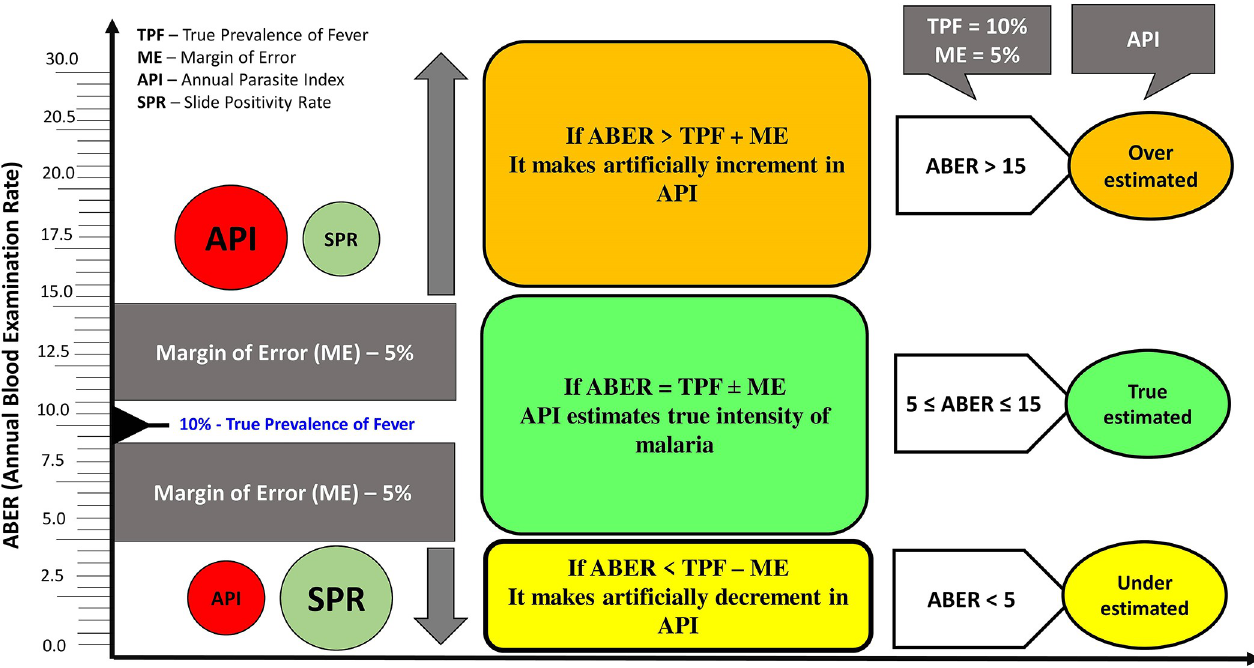
Fig 5. Schema of relationship between API, SPR, ABER and true prevalence of fever. https://doi.org/10.1371/journal.pgph.0000326.g005 with API < 1) despite Ganjam having a slightly higher number of cases. Even Koraput (district of Odisha) and Naraynpur (district of Chhattisgarh) have similar caseloads but considerable variation in API due to varying population size and ABER; on the other hand, SPR seems to be